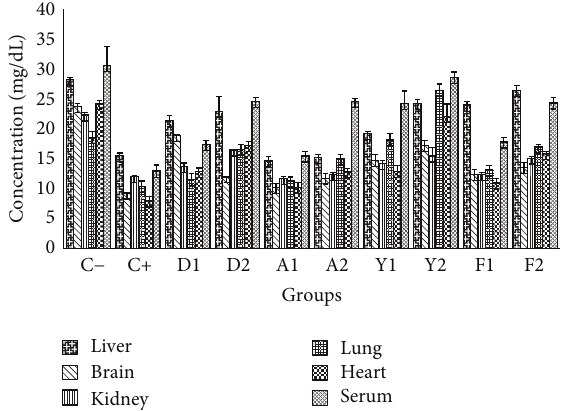
Figure 3: Effects of the extracts of yolk, albumen, and feed on total cholesterol profiles in liver, brain, kidney, lung, heart, and serum (mg/dL). Each value represents mean ( 𝑛 = 5 ).